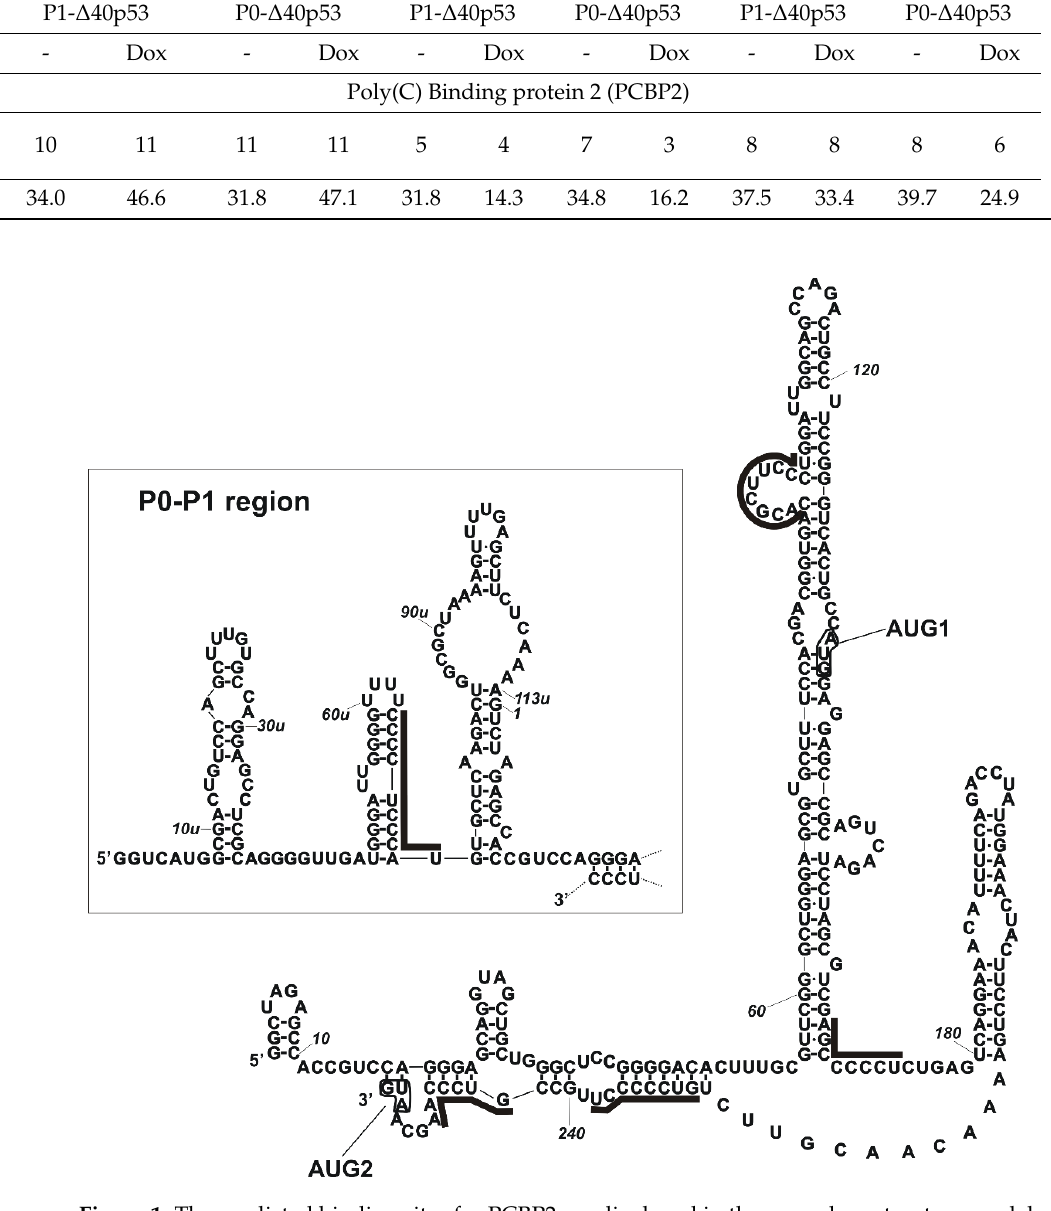
Figure 1. The predicted binding sites for PCBP2 are displayed in the secondary structure model of the 5 ′ -terminal region of p53 mRNA. Binding sites were defined based on the ATtRACT database and literature information [9,26]. Binding sites for PCBP2 are marked by continuous lines (GCCCC, UCCCC, UUCCC, CCCCC, AGCCC, GUCCC, CCCCU, CCCUCCC, CCUCCCA); The mRNA region which spans the transcription initiation sites P0 and P1 are shown in the inset.